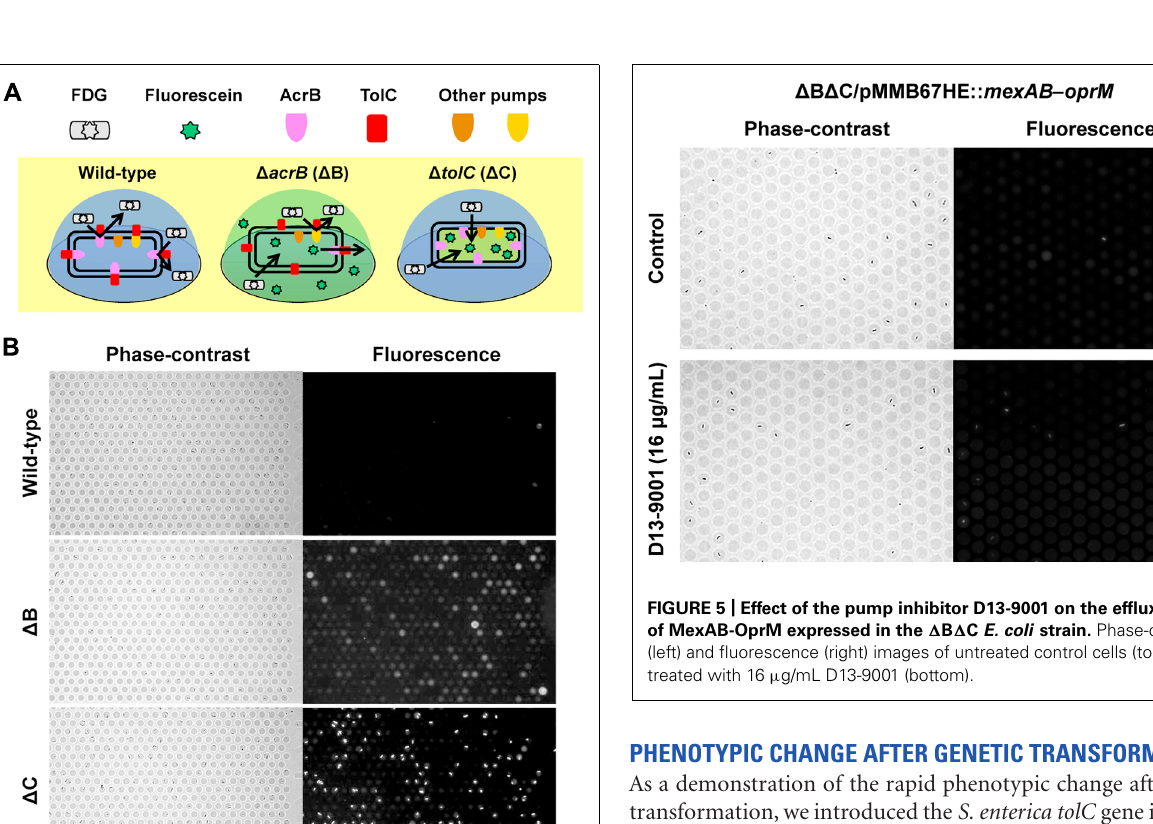
Frontiers in Microbiology | Antimicrobials, Resistance and